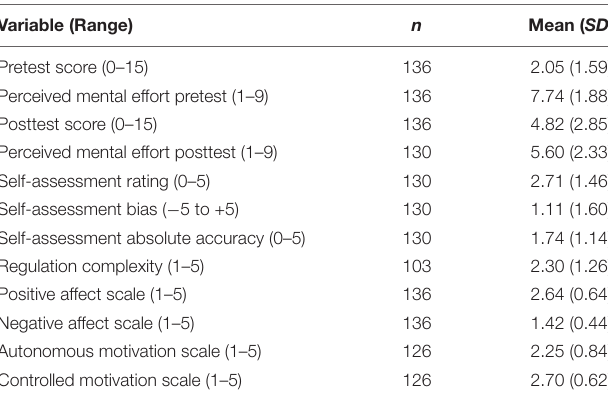
TABLE 1 | Means and Standard Deviations for performance, affect, motivation, and self-regulation variables. Variable (Range) n